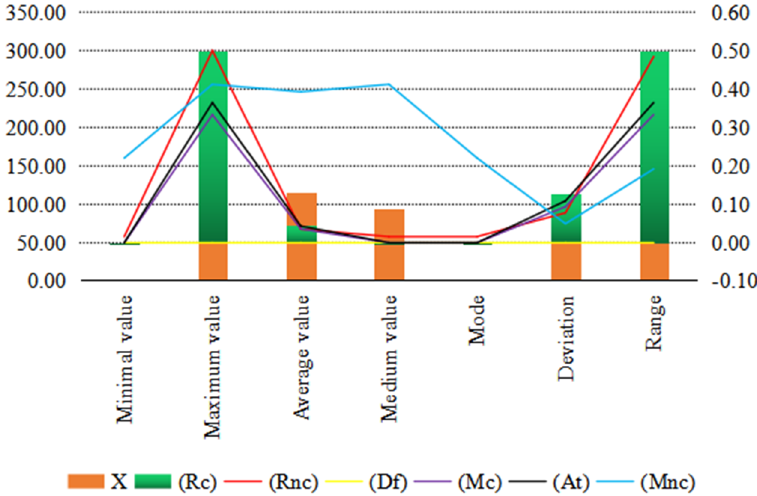
Figure 6. Analyses of rational nodes without defender strategies.